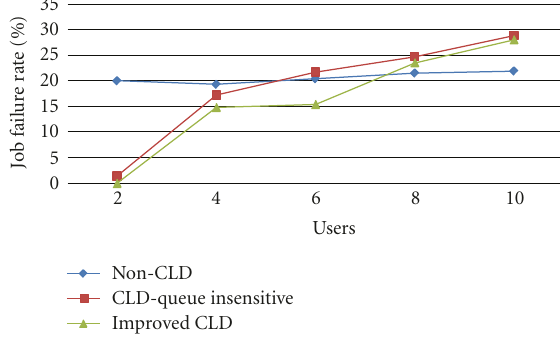
Figure 13: Average video